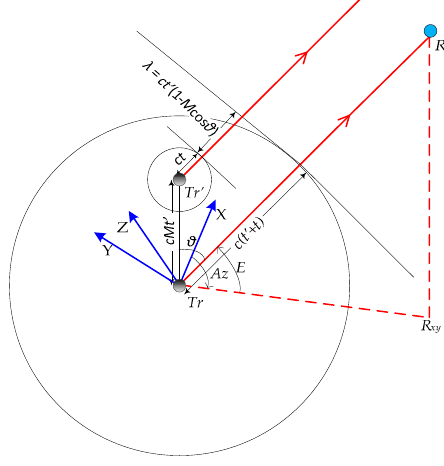
Figure 7. Doppler shift sound field.